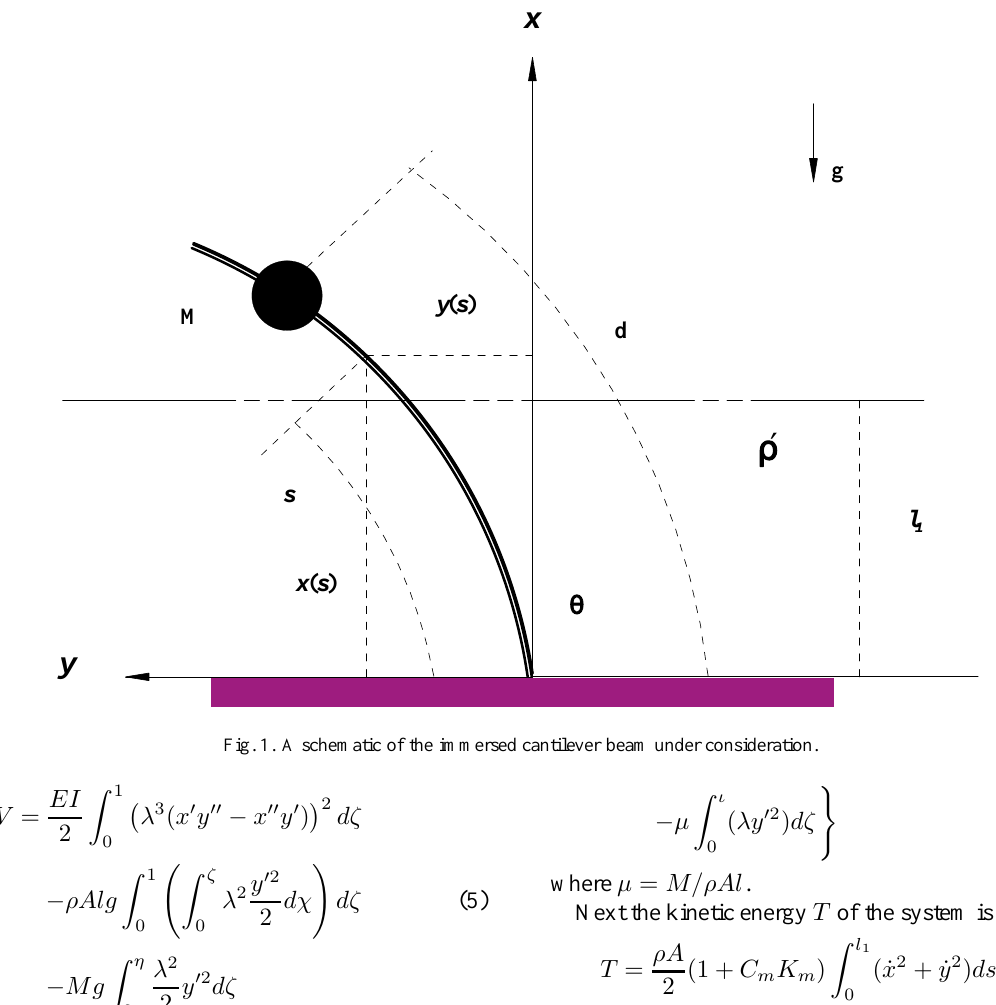
Fig. 1. A schematic of the immersed cantilever beam under